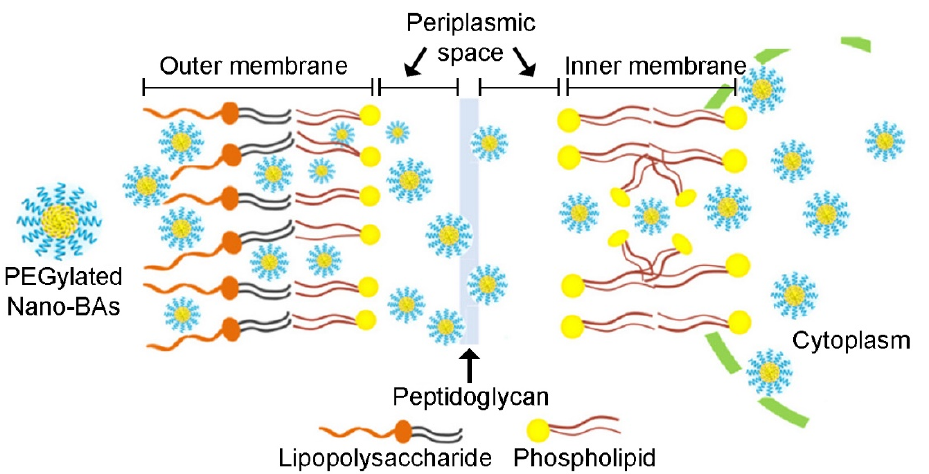
Figure 7. Proposed mechanism of action on Gram-negative bacteria of bacitracin-polymer nanosized micelles (PEGylated Nano-BAs) through LPS interaction. Reprinted with permission from Ref. [142]. Copyright 2018 American Chemical Society.